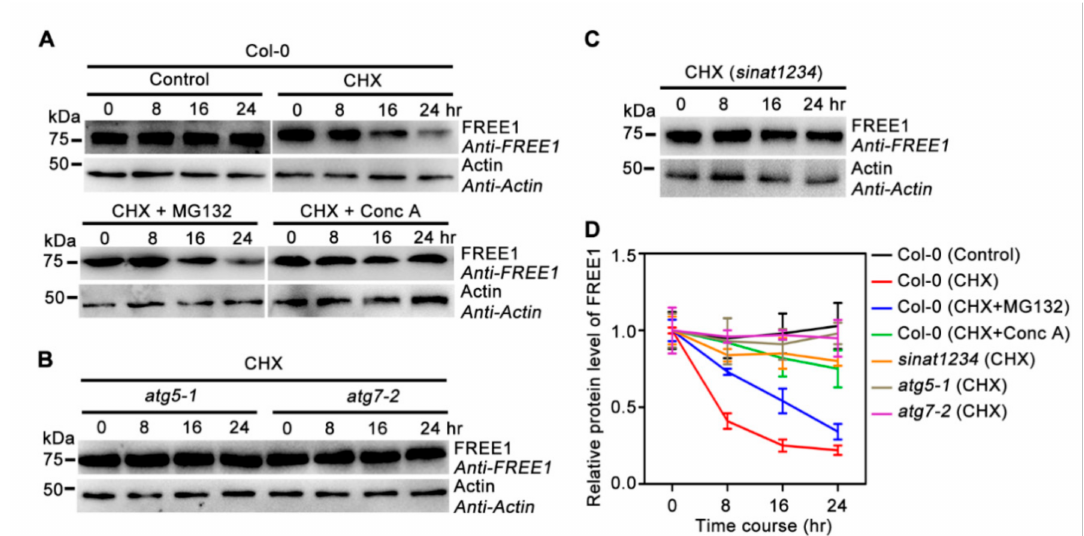
Figure 1. Autophagy-dependent degradation of FREE1. ( A ) Endogenous FREE1 levels in 7-d-old Col-0 seedlings upon DMSO (Control), 100 µ M CHX, 100 µ M CHX + 50 µ M MG132 and 100 µ M CHX + 0.5 µ M Conc A treatments for 0, 8, 16 and 24 h. ( B ) The degradation profiles of FREE1 in atg5-1 and atg7-2 upon 100 µ M CHX treatment for 0, 8, 16 and 24 h. ( C ) The degradation profile of FREE1 in sinat1234 upon 100 µ M CHX treatment for 0, 8, 16 and 24 h. ( D ) Quantification of the relative level of FREE1 protein under the indicated backgrounds or treatments. Values stand for the relative grayscale intensities of FREE1 normalized to actin and the first lane in each experiment was set as 1. Data represented as mean ± SD from three independent